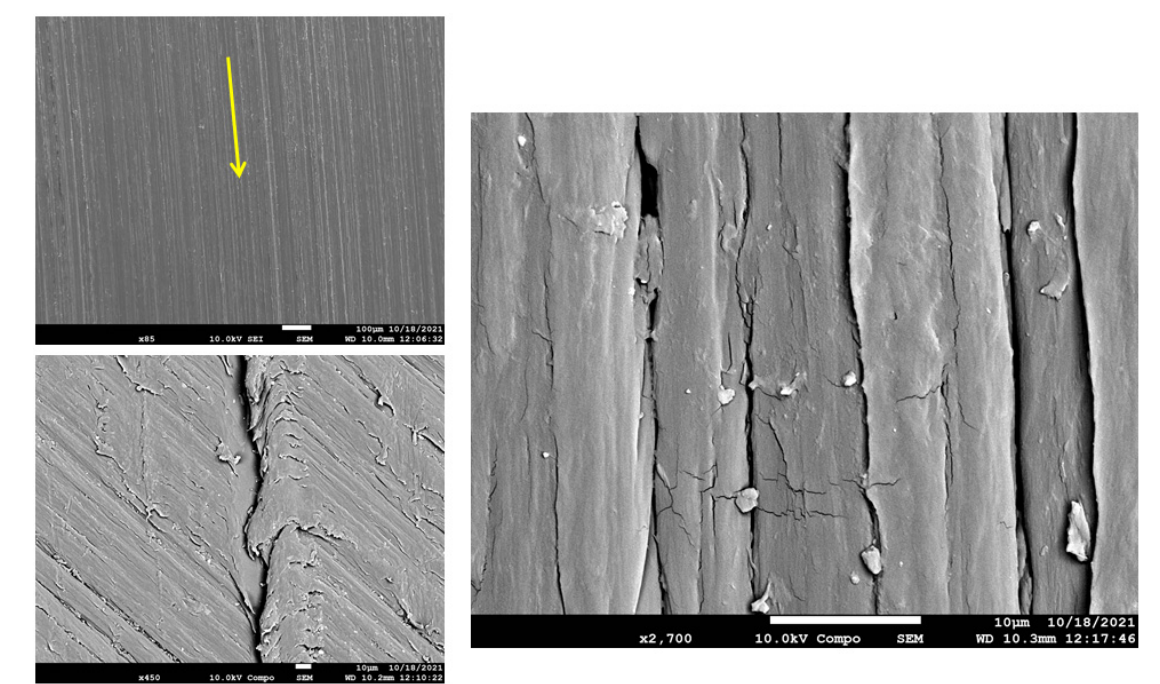
Figure 14. FESEM Micrographs for the worn-out surfaces of PA6 at different magnifications.